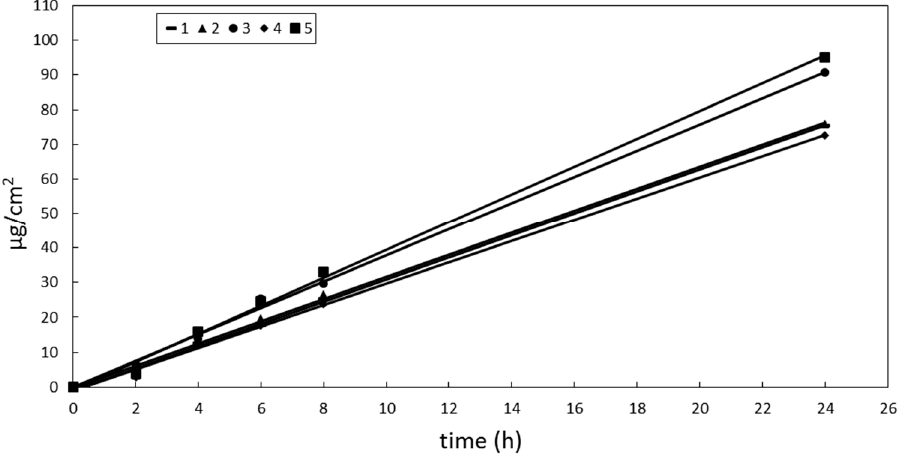
Figure 1. Cumulative amount of OMC released from vehicles 1–5 vs time. Standard error bars were omitted for clarity. The maximum coefficient of variation (CV = SD/mean × 100%) of the data was 18.